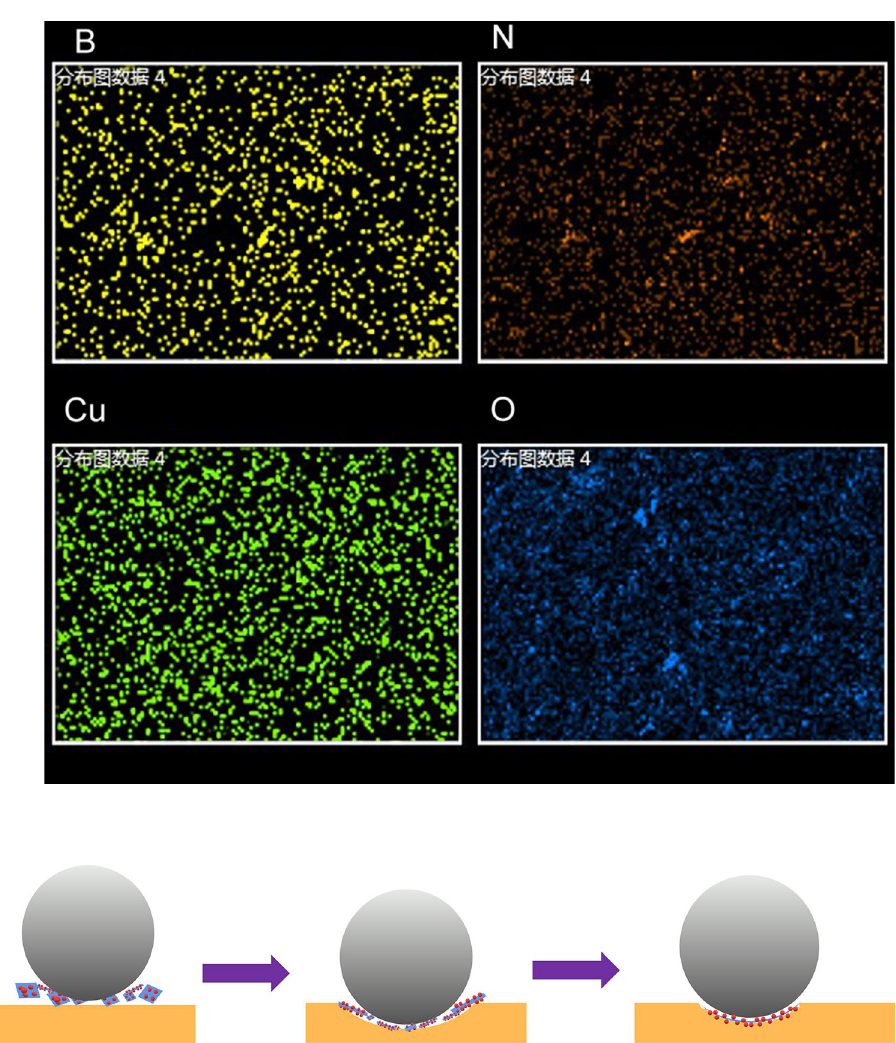
Fig.13 Element distribution of B, N, Cu and O on worn surface of oil with CuO@BNNS